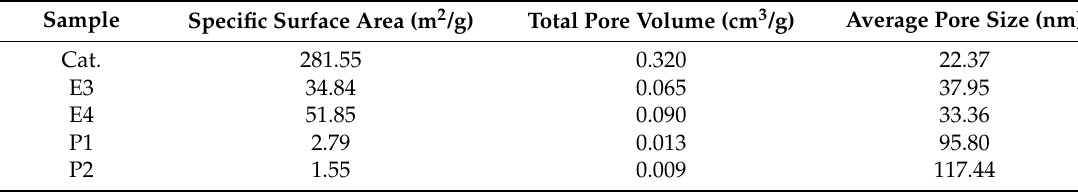
Table 2. Structural parameters of catalyst and nascent polymer/catalyst